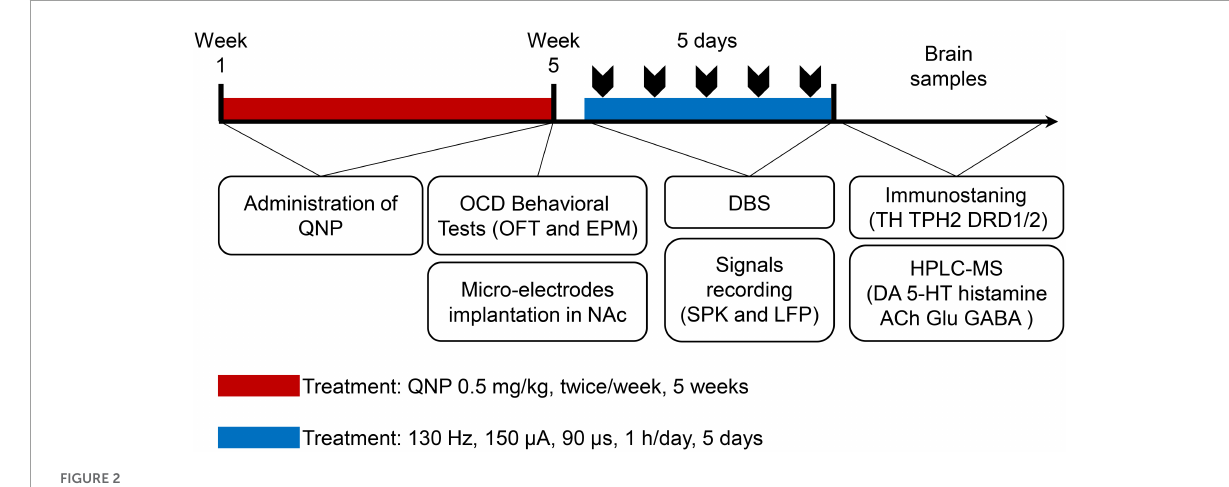
FIGURE2 Graphical presentation of the timeline of the whole experiment design.